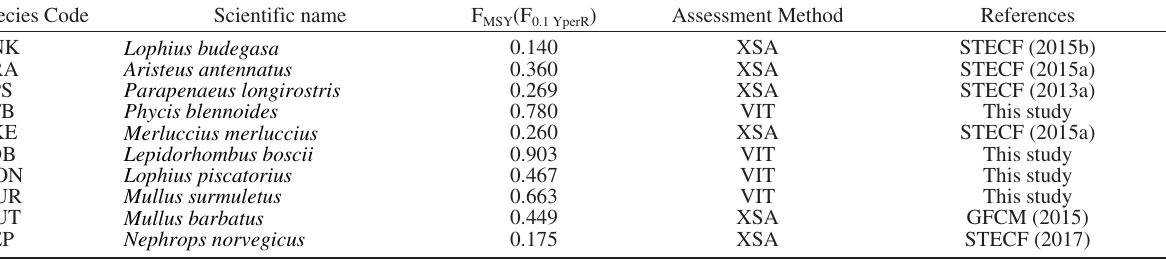
Table 7. – F estimated in the assessments. These F values are used as a reference for calculating the F/FMSY ratio resulting from the MSY MSY MEFISTO scenarios. Species codes as in Table 1.